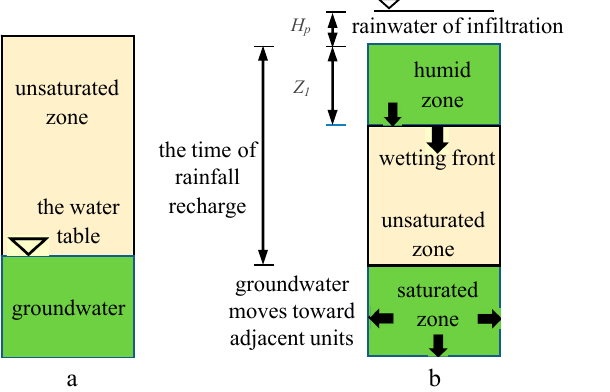
Figure 4. Slope rain seepage schematic diagram. ( a ) Initial stage rainfall. ( b ) Rainfall seepage path.